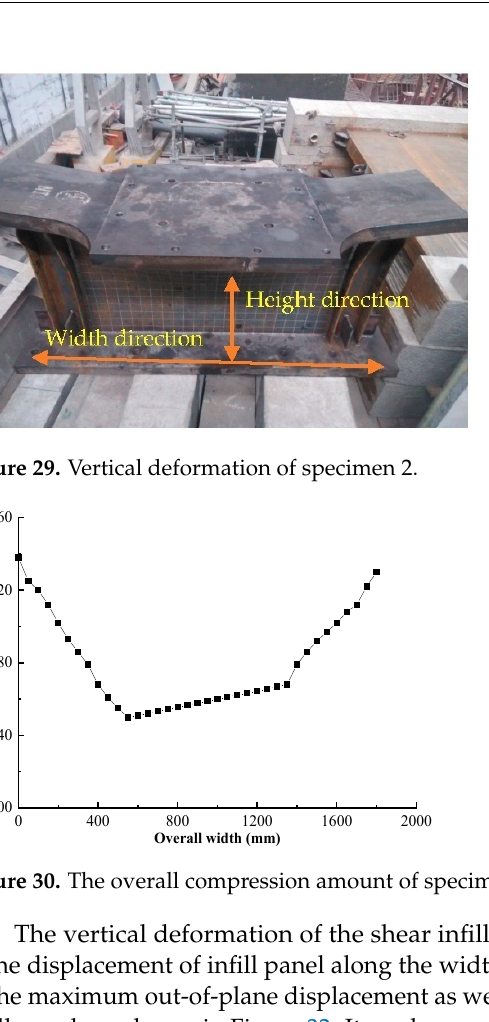
Figure 29. Vertical deformation of specimen 2.